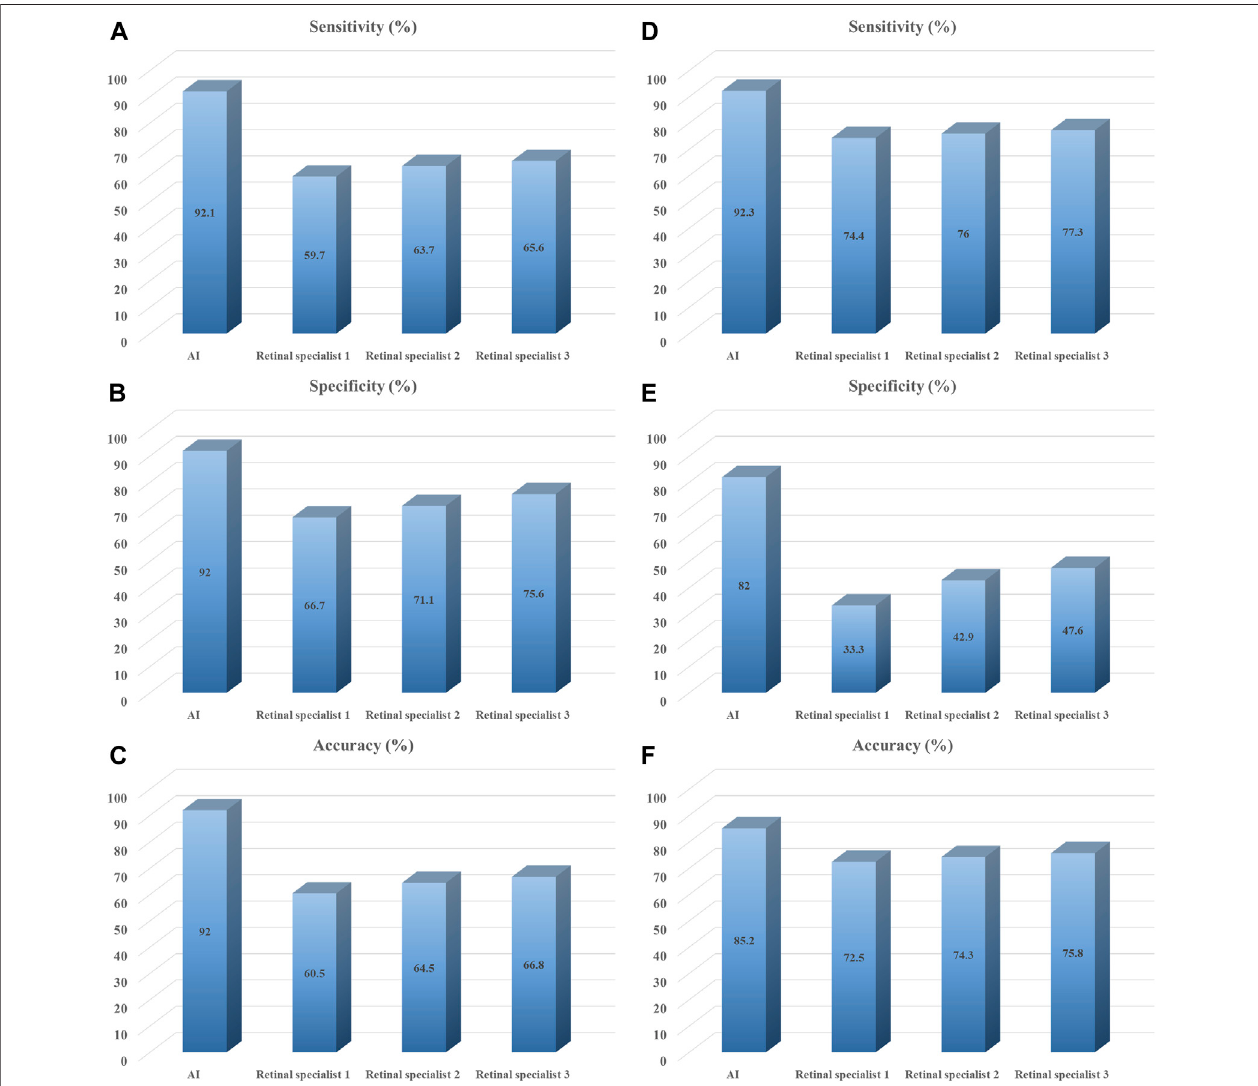
FIGURE 4 | Performance of deep learning models vs. retinal specialists in test set. Summary of classi fi cation results by deep learning models and three retinal specialists on testing data set. (A – C) Identi fi cation performance of SRD; (D – F) Discern performance of macula-on SRD. Retinal specialist 1 with 3 years of working experience at a physical examination center; retinal specialist 2 with 5 years of working experience at a physical examination center; retinal specialist 3 with 10 years of working experience at a physical examination center.